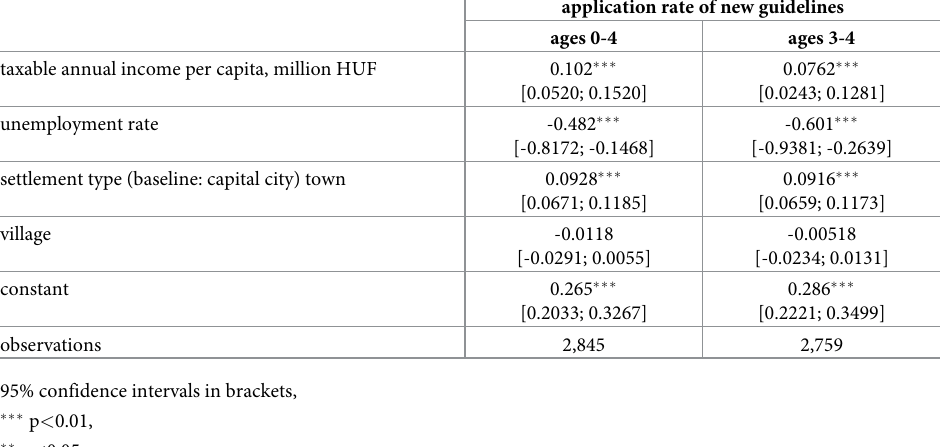
Table 2. Settlement level linear regressions of the rate of application of the new prescription guidelines, August 2016-February